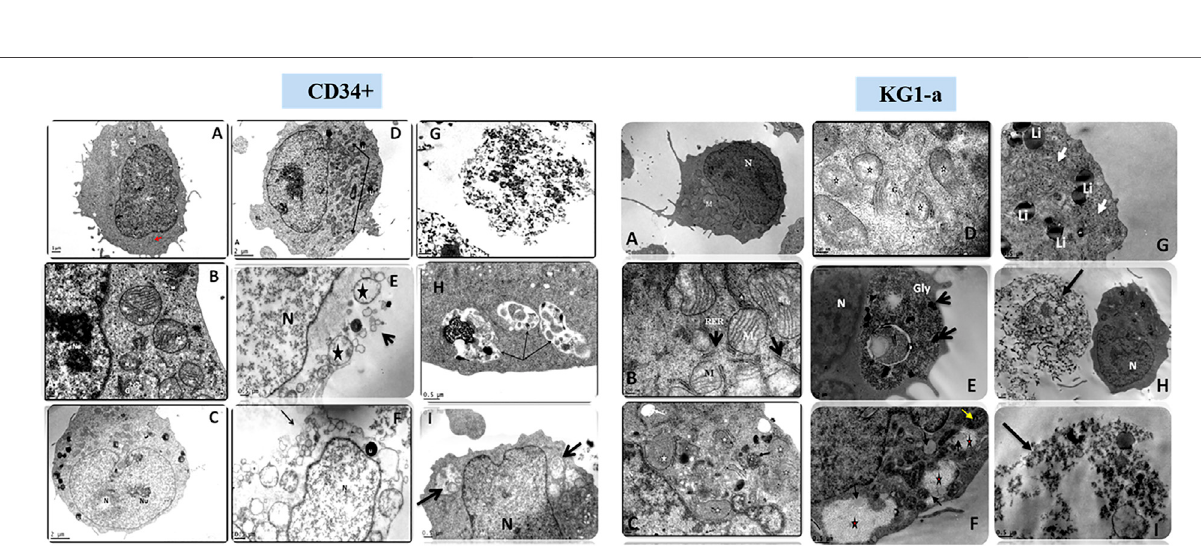
are predominantly cationic, amphipathic molecules. Their selectivity arises from a primary electrostatic interaction of their charged surface with negatively charged prokaryotic